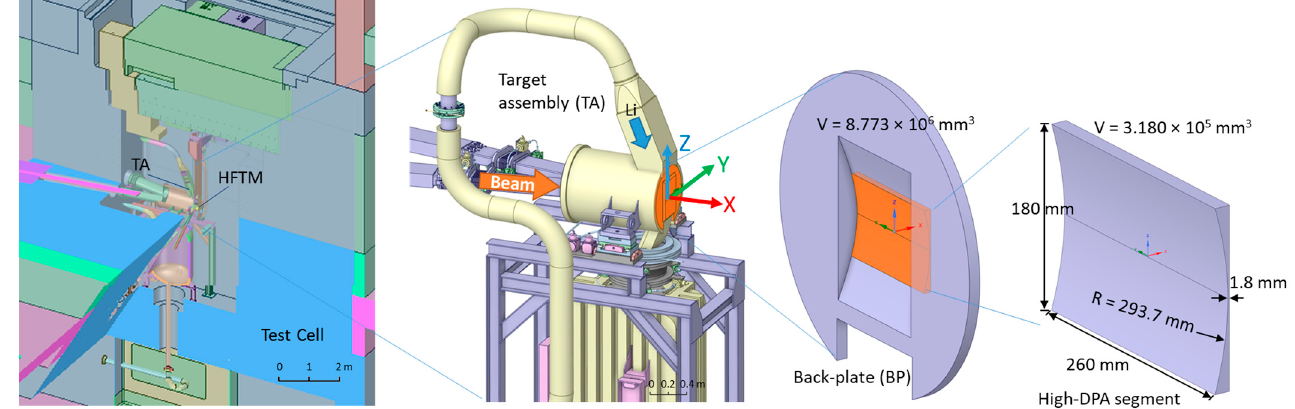
Figure 1. Geometries of the test cell, target assembly, and the back-plate.